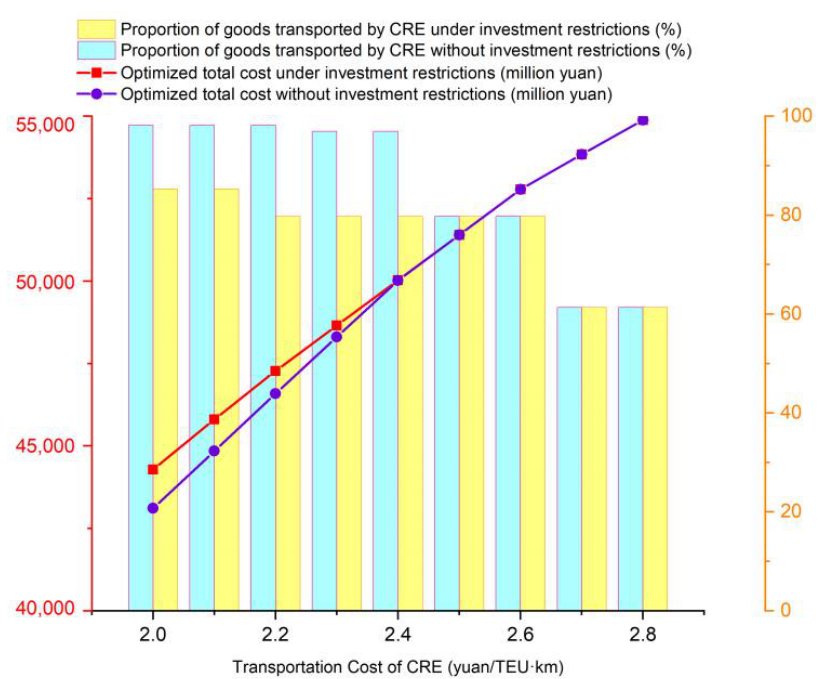
Figure 7. Changes in the proportion of CRE and total optimization costs when CRE transport costs and investment limits are changed.